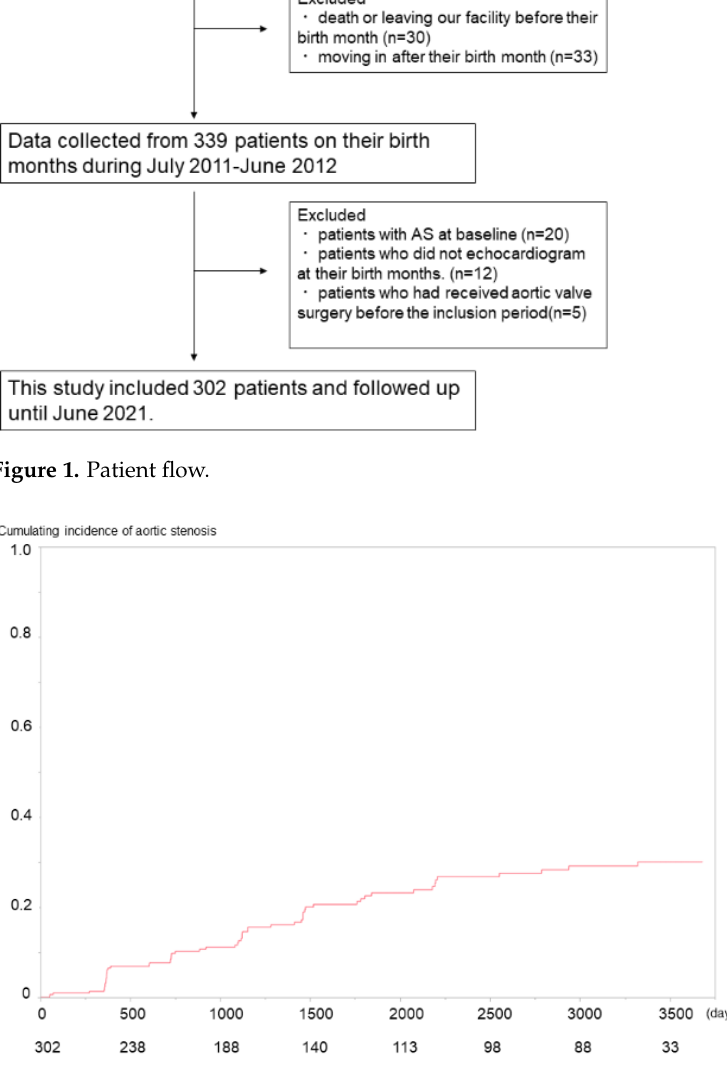
Figure 2. Cumulative incidence of aortic stenosis. The number below the graph shows the number of patients at risk.